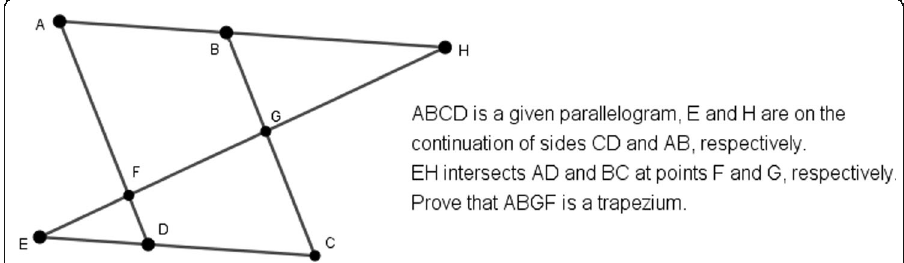
Fig. 6 Samples of sentences that can be built by language